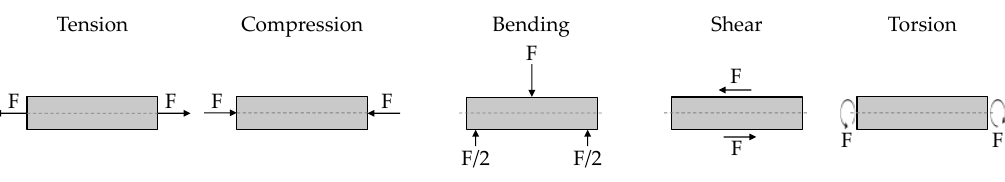
Figure 2. Overview of different load types.